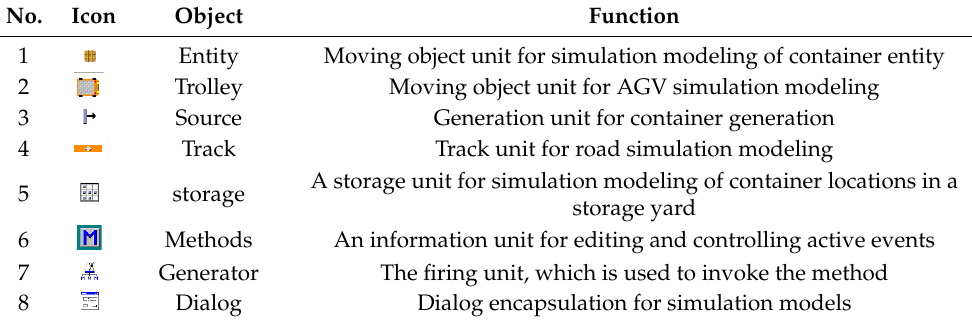
Table 3. Basic modeling